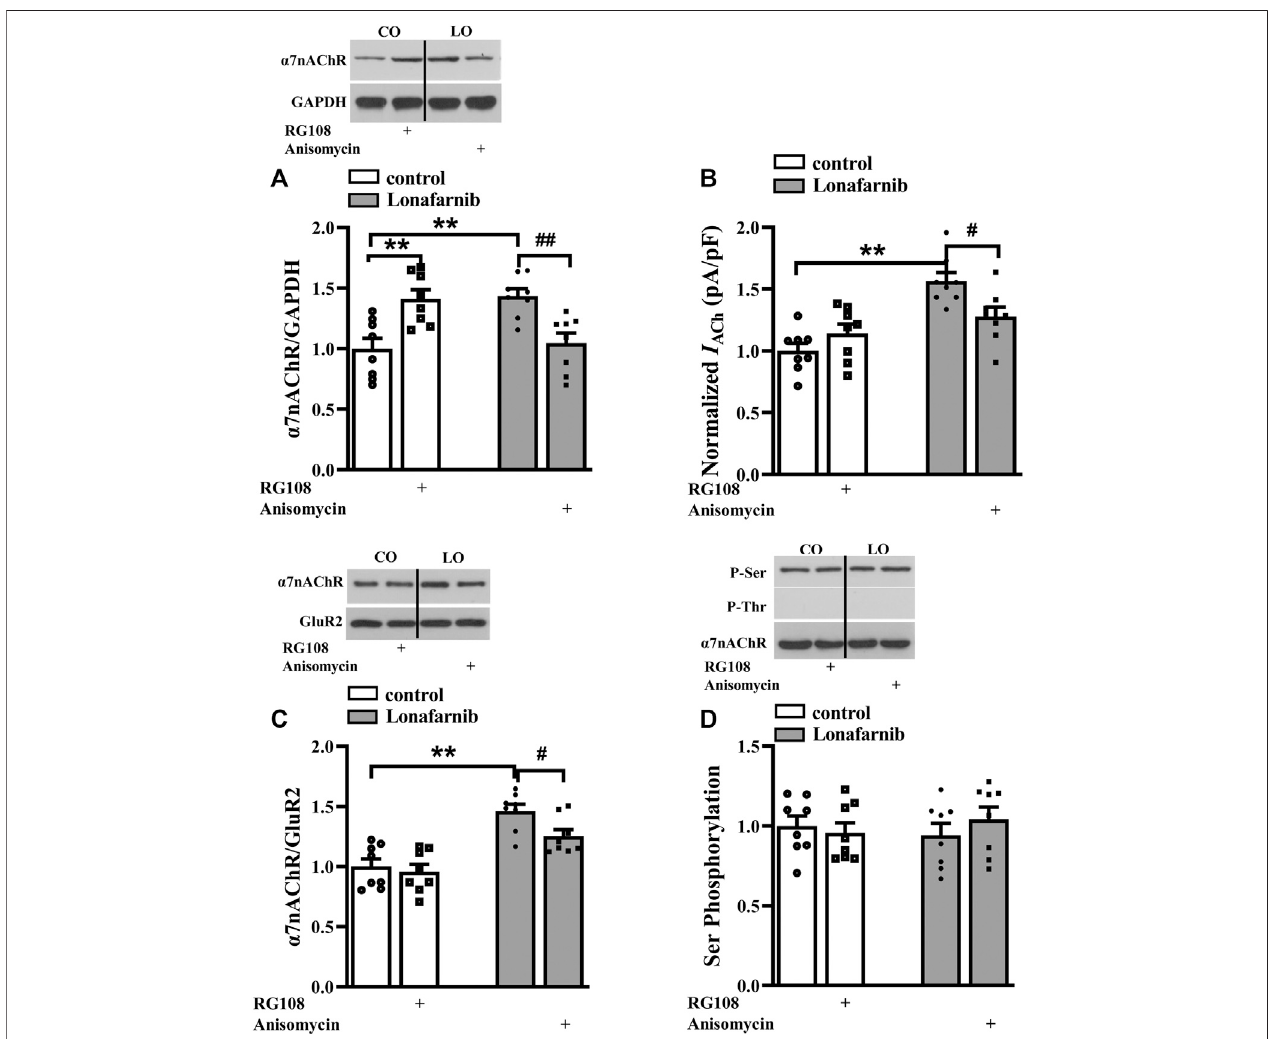
FIGURE 4 | Role of DNA methylation in the lonafarnib affected activity, total expression, membrane expression, and phosphorylation of a7nAChR. (A) Levels of a7nAChRtotalproteinsinthehippocampusofcontrolandlonafarnib-treatedmicetreatedwithvehicle,DNMTinhibitorRG108oranisomycin.** P < 0.01vs.controlmice, ## P < 0.01 vs. lonafarnib-treated mice (two-way ANOVA, followed by Tukey ’ s multiple comparison test). (B) Evoked I ACh by ACh (3 mM) in the slices of control and lonafarnib-treatedmicetreatedwithvehicle,RG108,oranisomycin,** P < 0.01vs.controlmice; # P < 0.05vs.lonafarnib-treatedmice(two-wayANOVA,followedby Tukey ’ s multiple comparison test). (C) Levels of biotinylated a7nAChR (membrane surface) protein in the hippocampus of control and lonafarnib-treated mice treated with vehicle, RG108, or anisomycin. Surface a7nAChR was normalized by surface GluR2 protein, which was again normalized by vehicle-treated control group. ** P < 0.01 vs. control mice; # P < 0.05 vs. lonafarnib-treated mice (two-way ANOVA, followed by Tukey ’ s multiple comparison test). (D) Levels of phospho-a7nAChR in the hippocampus of control and lonafarnib-treated mice treated with vehicle, RG108, or anisomycin. The expression of protein and the amplitude of evoked I ACh were normalized by the values of control group with